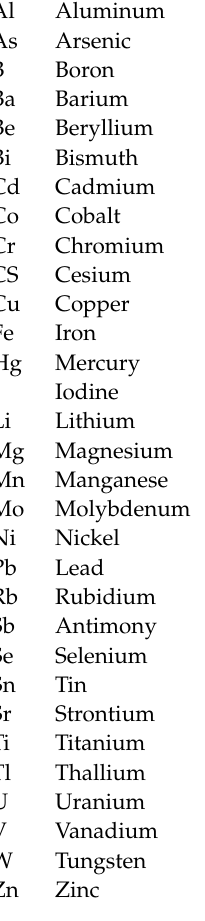
List of key abbreviations used in Table